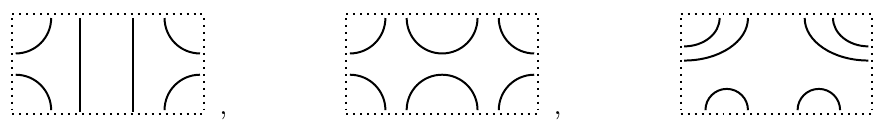
Figure 1 . Examples of affine diagrams for L = 4 , with the left and right sides of the framing rectangle identified, so as to form an annulus. The first diagram represents the generator e second is e , and the third is e 2 e 4 4 e 3 e 1